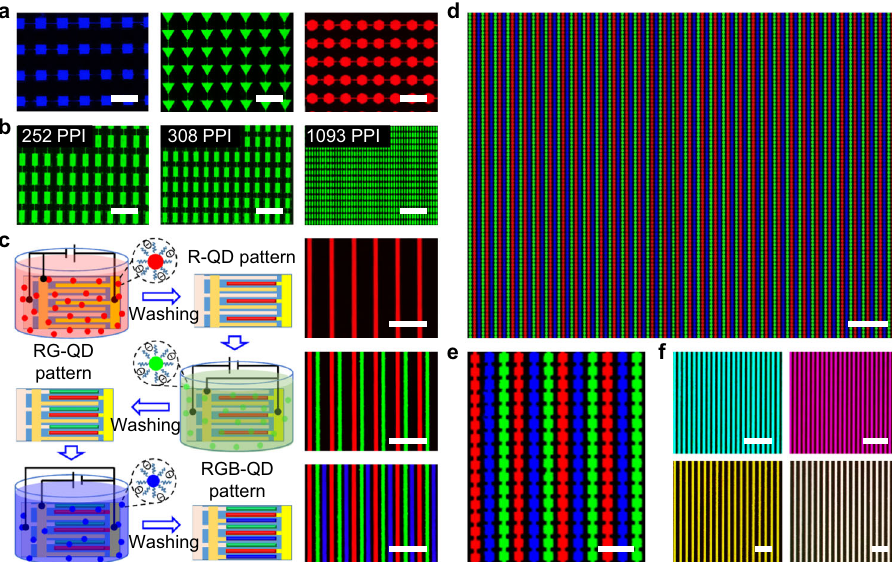
Fig. 3 SEPD for full-color QDs pattern arrays. a , b Fluorescence images of an array of different QD patterns under UV light (blue square pattern, green triangle pattern, and red hexagon pattern). The PL images showing aligned pixels whose resolution are ranging from 252 to 1,093 PPI (Fig. 3b). Scale bars, 200 μ m. c Schematic illustration and corresponding fl uorescence images of sequential SEPD red, green, and blue QDs for fabricating full-color patterns of QDs. After each SEPD process, the substrate is washed by pure solution. Scale bars, 200 μ m. d , e Fluorescence images of RGB QD patterns fabricated by three-step SEPD. Figure 3e is a magni fi ed view of Fig. 3d. Scale bars are 200 and 50 μ m, respectively. f PL microscopy images of multi-color and white vertical patterning fabricated by multi-step depositing different QDs on the same electrode, which demonstrates the SEPD QD fi lms can be stacked vertically, as well as horizontally. Scale bars, 100 μ m.